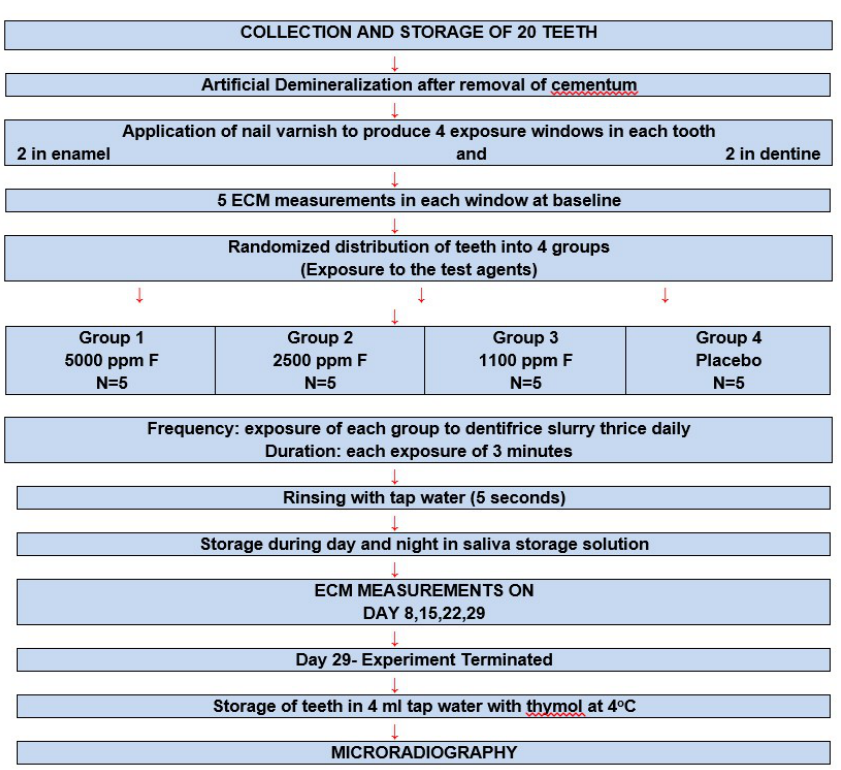
Figure 1. For testing fluoride dentifrice remineralization.